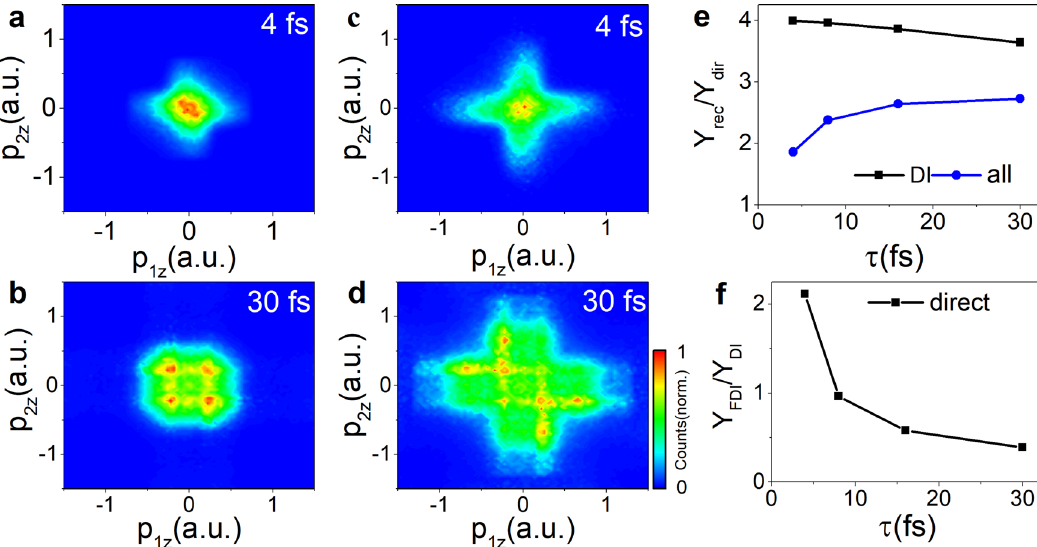
Fig. 3 Distributions corresponding to recolliding trajectories and direct trajectories of e 2 . a , b Correlated electron momentum distributions (CEMDs) corresponding to direct trajectories of e 2 . c , d CEMDs corresponding to recolliding trajectories of e 2 . e Pulse-duration dependence of Y rec / Y dir , the ratio between the integrated yields of recolliding and direct trajectories for e 2 for all events or only double ionization (DI) events. f Pulse-duration dependence of Y Y FDI / DI , the ratio between the probabilities of frustrated double ionization (FDI) and DI when 1.25 × 10 14 W cm − 2 . Each CEMD is normalized to itself. The carrier-envelope phases are